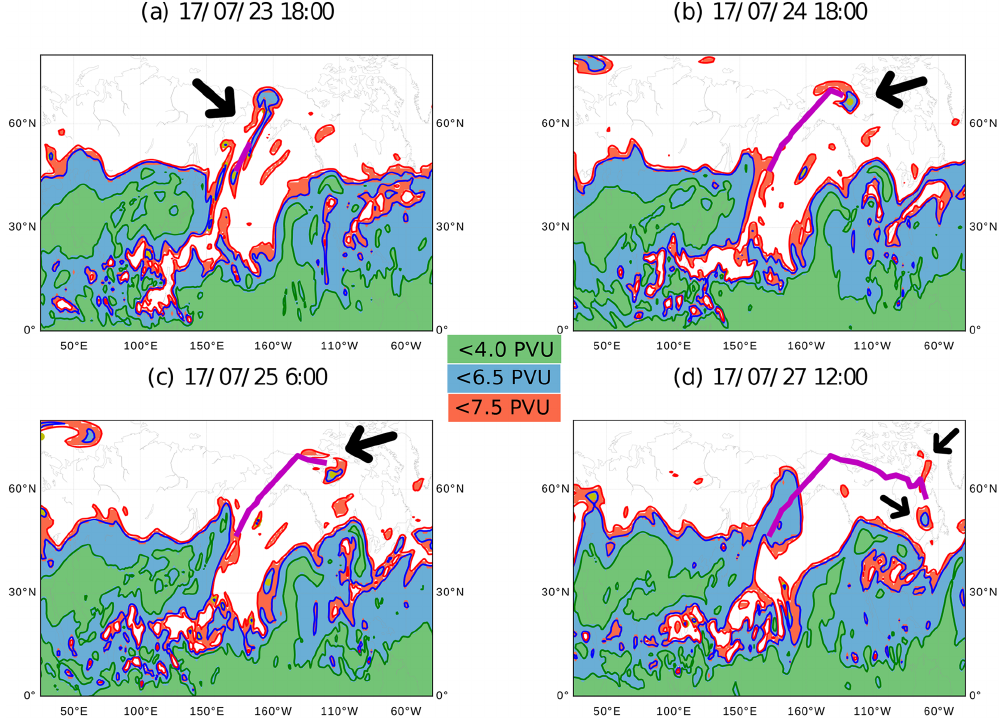
Figure 10. Example of an eastward shed 7.5PVU cutoff from the ASMA at 380K. Colours are as in Fig. 2. The violet line shows the track of the moving 7.5PVU cutoff.